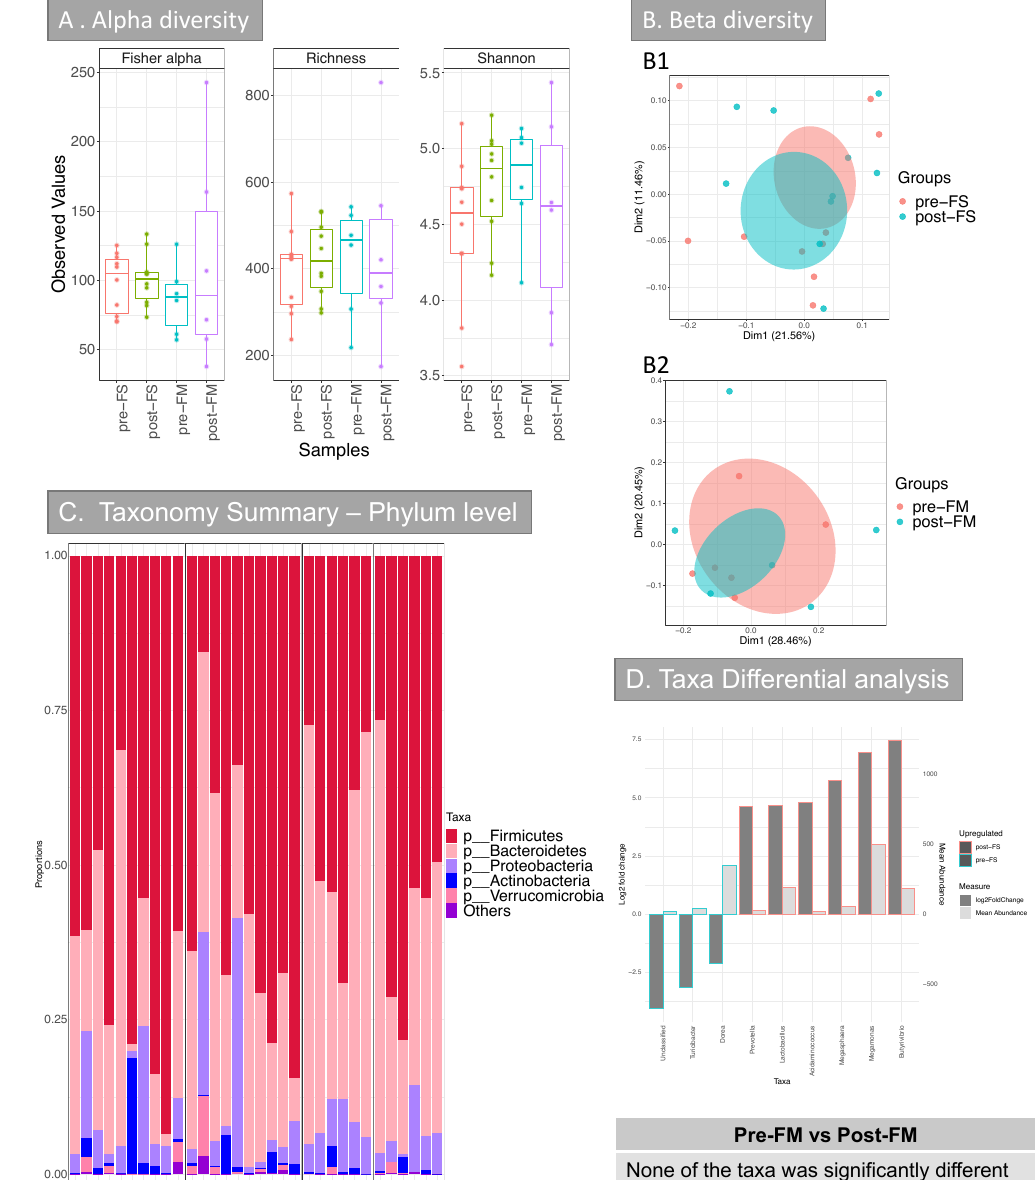
Figure 6. Alpha and Beta diversity, and taxonomy results of the intestinal microbiome (Human cohort). ( A ) Alpha diversity (OTUs level) of the intestinal microbiome from the 4 groups: pre-FS, post-FS, pre-FM, post-FM. Three indices were considered: Fisher alpha (a parametric index that models species’ abundance as logseries distribution), richness (number of species) and Shannon index (a widely used index that considers species’ abundance and evenness). Pair-wise ANOVA was calculated between the groups, but none was significant. ( B ) Beta diversity results ( B1/B2 ) Principal Co-ordinate Analysis (PCOA) showing c—-lustering of samples. The chart was produced using unweighted UniFrac (UniFrac) at OTUs level. Ellipses are 95% confidence interval of standard error. PERMANOVA analysis comparing the groups for all the distances (Bray-Curtis, unweighted UniFrac (UniFrac) and weighted (W. UniFrac)) were not significant. ( C ) Taxonomy summary at phylum level. ( D ) Taxa differential analysis at genus level are presented through bar charts, which show Log2 fold change between pre-FS vs. post-FS samples, ( y axis on the left and dark grey bar) and the mean abundance across all the samples ( y axis on the right and light grey bar). The comparison of samples from patients that were given FM before and after treatment (pre-FM vs. post-FM) did not give any significant results at any of the taxonomical levels analysed (phylum, class, order, family, genus and OTUs). Detail of taxa differential analysis results, including p values and adjusted p values, is in Supplementary Table S3. FS = ferrous sulphate and FM = ferric